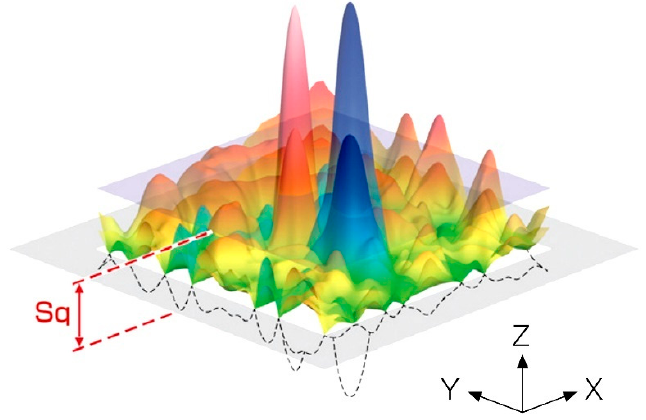
Figure 5. Graphical illustration of the surface roughness parameter Sq [39].